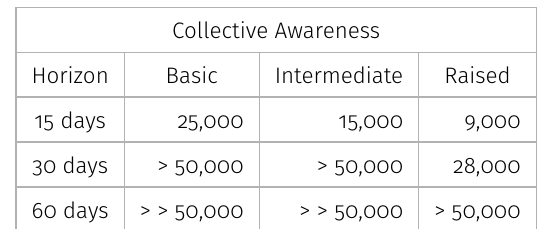
Table III. Collective Awareness – number of cases (Day 0 = April 6 th ,